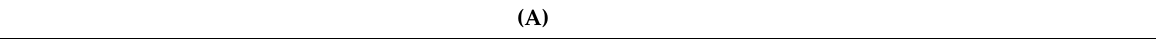
Table 1. Population